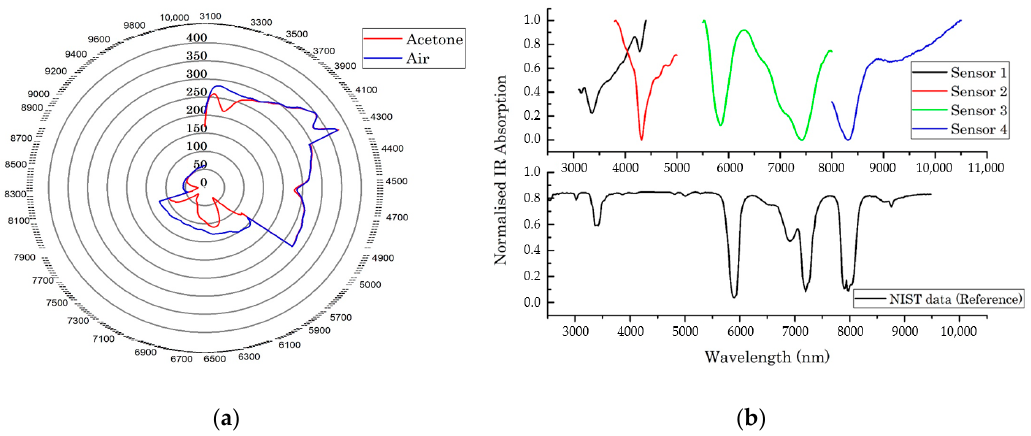
Figure 12. Optical electronic nose responses: ( a ) ambient air and acetone in water, across the entire infrared range (3.1–10.5 µm); and ( b ) acetone absorption frequencies.